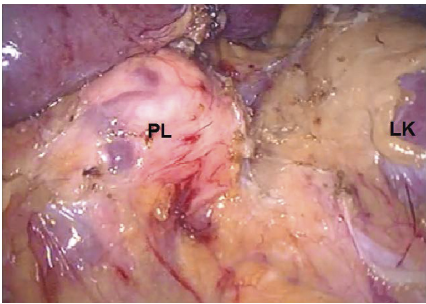
Figure 3: Intraoperative picture. LK: left kidney; S: medially mobilized spleen; PL: retroperitoneal lesion of the posterior pan- creatic surface. The distal pancreas is medially mobilized.